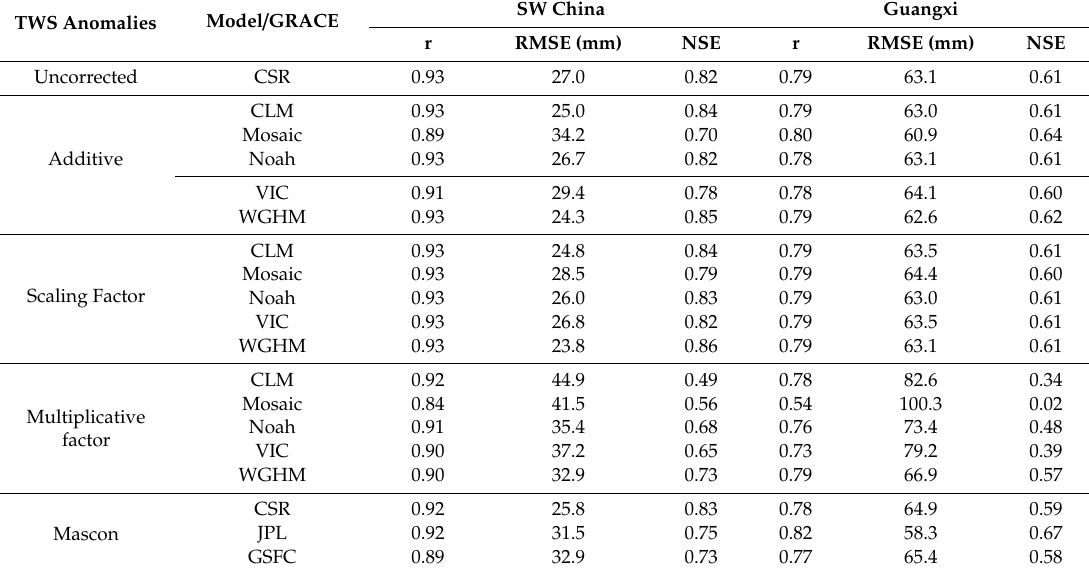
Table 3. Statistics of r, RMSE and Nash–Sutcli ff e e ffi ciency coe ffi cient (NSE) between leakage-corrected and in situ TWS, and between mascon-based and in situ TWS. All the correlations (r) are evaluated using a two-sided 1% level significance (i.e., p <